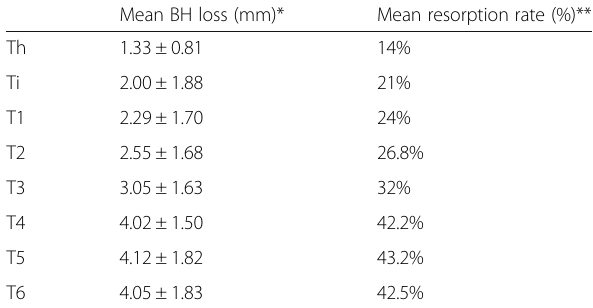
Table 3 Mean bone height (BH) loss and mean resorption rate over